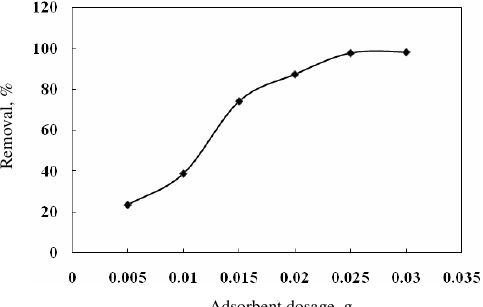
Figure 5. Effect of PtN-AC dosage on CR removal at dye concentration of 15 mg L -1 in 200 mL, at pH 4 and room temperature